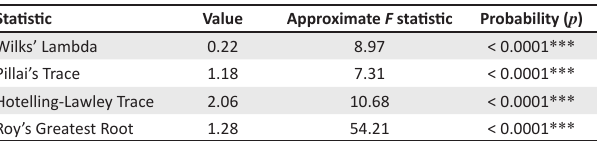
TABLE 3b: Canonical correlation analysis ‒ Overall model fit statistics